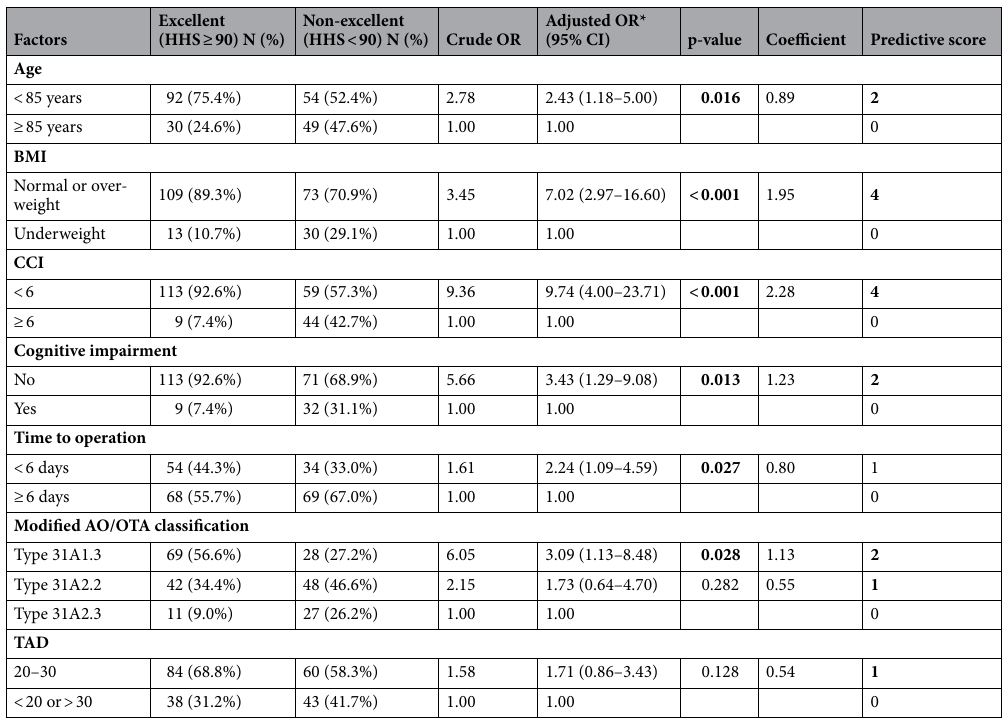
Table 4. Univariate and multivariate analysis, and predictive score for excellent outcome in development cohort. OR Odds Ratio, 95% CI 95% confidential interval, HHS Harris Hip Score, 1.00 Reference. *Adjusted for Age, BMI, Cognitive impairment, DM, Hypertension, Dyslipidemia, Chronic kidney disease, CCI, vitamin D, Operative time, Operative blood loss, TAD, Modified AO/OTA, Length of hospital stay. Significant values are in bold.